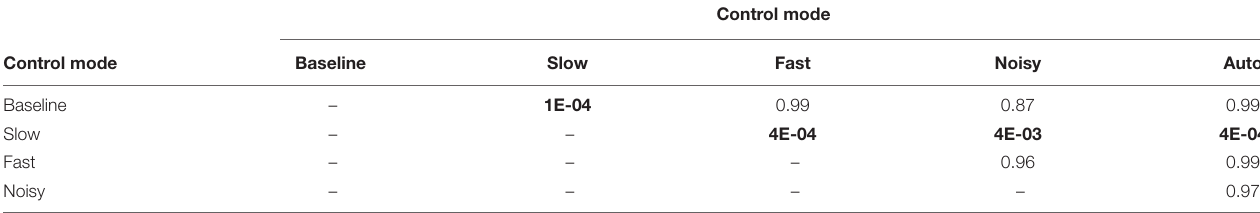
TABLE 1B | Post hoc comparisons ( p -values) between control modes for implicit agency.